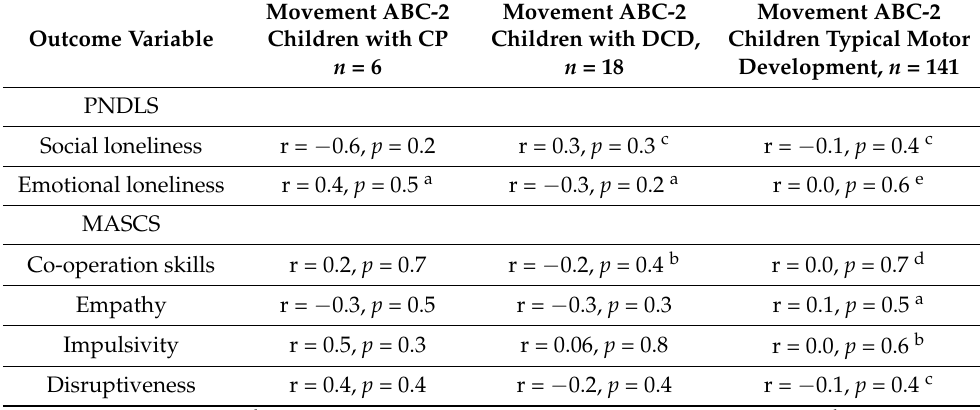
Table 3. Outcome characteristics of the 11-year-old children born very preterm. Motor outcome was assessed with the Movement Assessment Battery for Children, Second Edition (Movement ABC-2). Social functioning was assessed with the Multisource Assessment of Children’s Social Competence Scale (MASCS) and loneliness was assessed with the Peer Network and Dyadic Loneliness Scale (PNDLS). Pearson’s correlation was used to study the univariate associations between two continuous variables. n = number of assessed children, r = Pearson correlation coefficient.